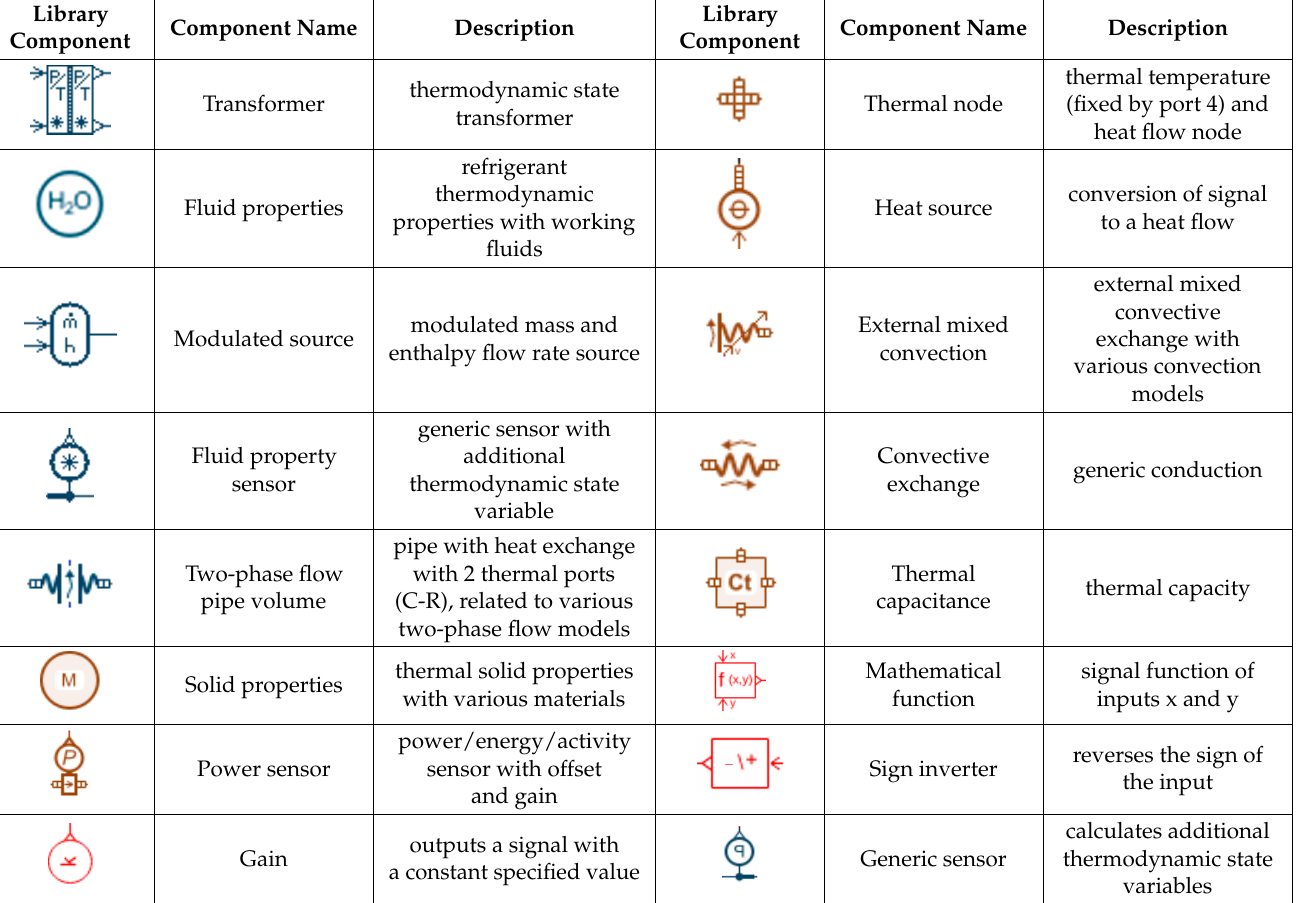
Figure 3. One-dimensional AMESIM modeling of the CAHP. Table 4. Main AMESIM library components used in the CAHP model.